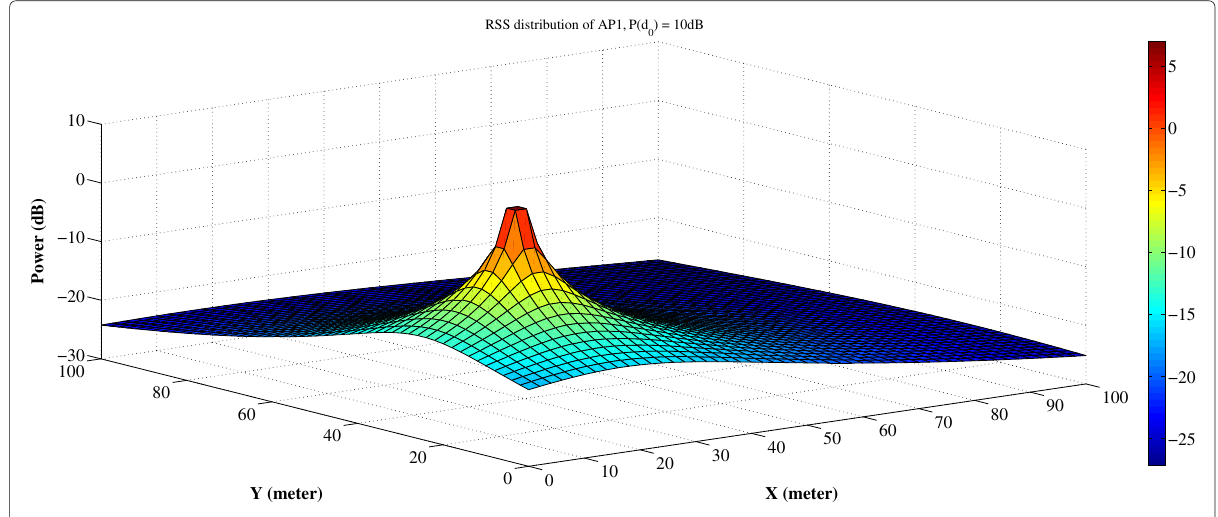
Fig. 8 RSS distribution of AP1. P ( d 0 ) = 10 dB, α = 1.8, d = 2 m, and σ = 5.2